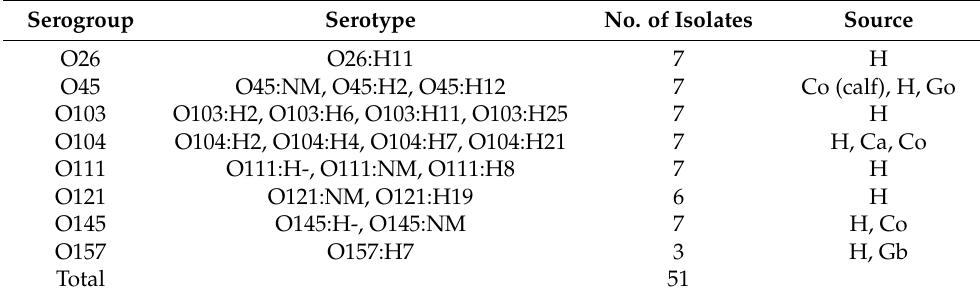
Table 1. Shiga toxin-producing Escherichia coli (STEC) isolates analyzed in this study. Serogroup Serotype No. of Isolates Source O26 O26:H11